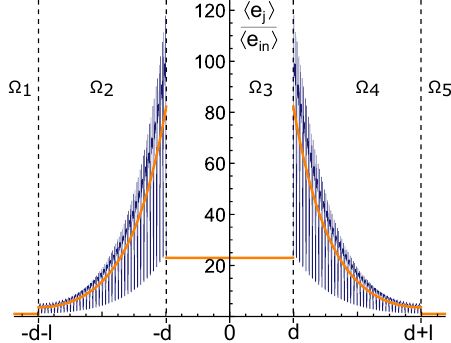
Figure 6. Ratio of the averaged mechanical energy density along the whole system, with respect to the incoming one. Orange: analytic results and blue: numerical results. Each part composing the REH is separated by the vertical dashed lines.